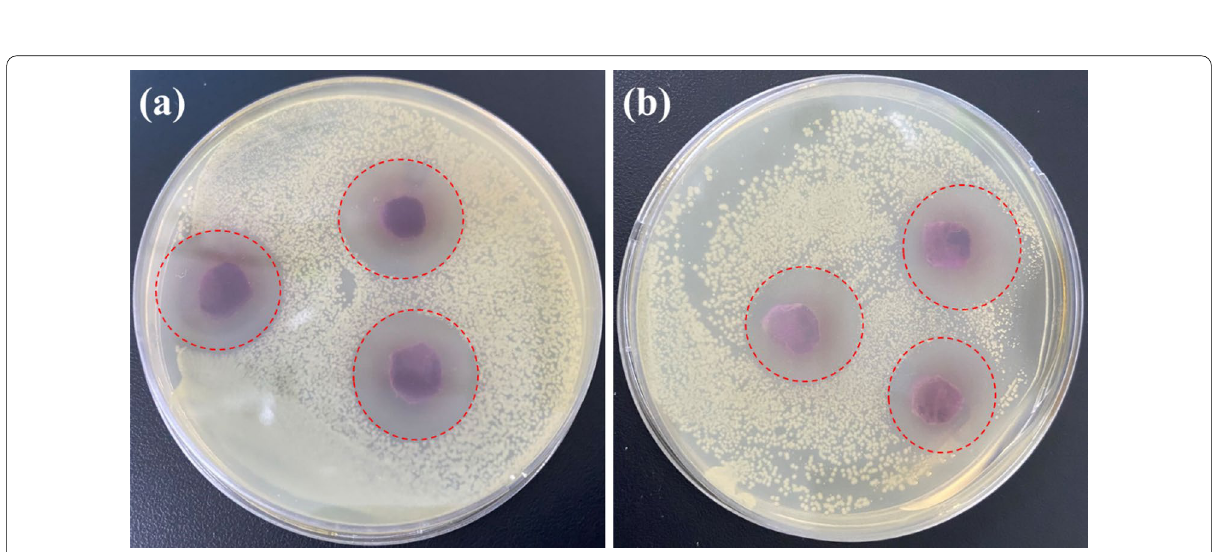
Fig. 9 Optical images of synthetic dye effluents adsorption ( a ) and removal efficiency of the regenerated ZIF-67/cotton fibers toward MG after 10 successive adsorption–desorption cycles in the simulated dye effluent ( b ) (adsorption conditions: mass of adsorbent, 100 mg; initial dye concentration, 20 mg/L; volume of dye solution, 50 mL)